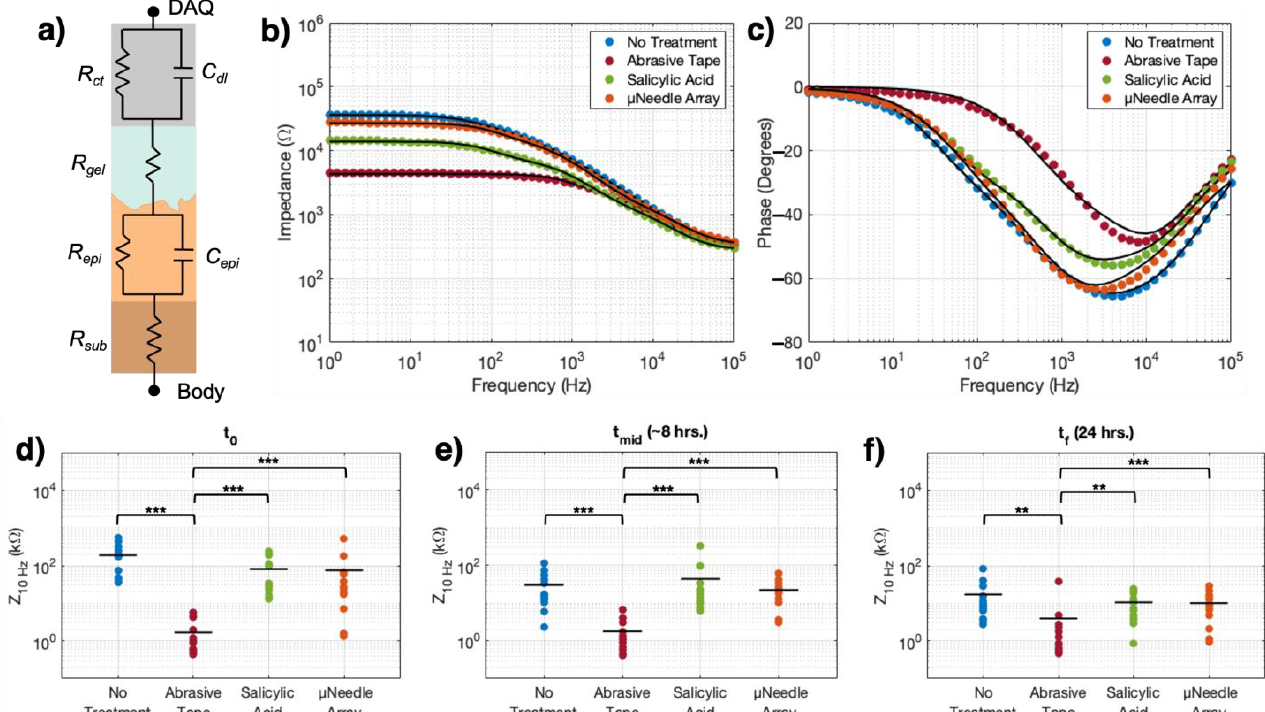
Figure 2. ( a ) Schematic of the equivalent circuit model used for fitting the skin – electrode impedance data. At the electrode level (top three elements): R ct is the charge-transfer resistance, C dl is the double-layer capacitance, and R gel is the gelled electrolyte resistance. At the skin level (bottom three elements), R epi and C epi are the epidermal resistance and capacitance, respectively, and R sub is the resistance of the dermis and subcutaneous fat layers. ( b , c ) Representative Bode plots of the impedance ( b ) modulus and ( c ) phase for one subject at the initial timepoint, for all skin treatments. Points represent measured experimental data, while solid black lines denote the fitted curves. ( d – f ) 10 Hz impedance values for all subjects, for all skin treatments, at the ( d ) initial ( t 0 ; ANOVA F(14,3) = 68.02, p < 1.5 × 10 – 15 ), ( e ) middle ( t mid ~8 hr.; ANOVA F(10,3) = 19.31, p < 5.0 × 10 – 4 ), and ( f ) final ( t f ~24 hr.; ANOVA F(10,3) = 19.17, p < 7.5 × 10 – 7 ) timepoints. Significance levels: (**) denotes p < 0.01, (***) denotes p < 0.001.